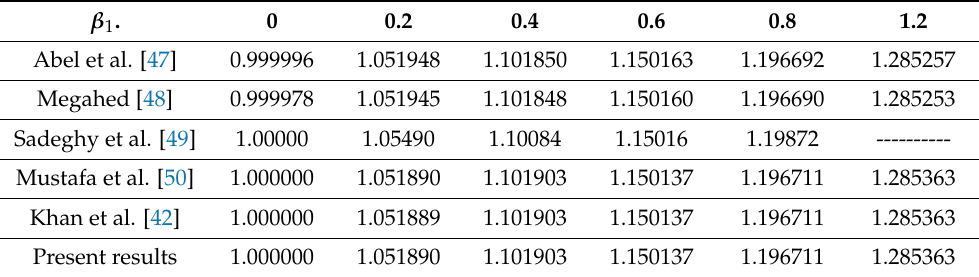
Table 1. An assessment − f (cid:48)(cid:48) ( 0 ) for some reduced cases. β 1 .